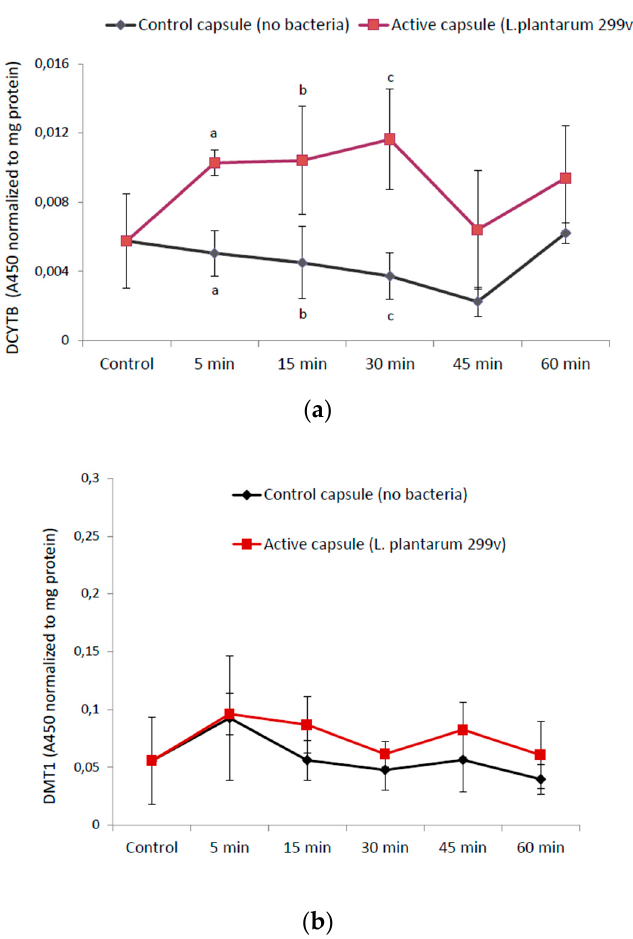
Figure 2. ( a ) Cellular level of the ferric reductase DCYTB was significantly increased in the presence of L. plantarum 299v ( p = 0.0008 at 5 min, p = 0.03 at 15 min, p = 0.004 at t = 30 min) as indicated with